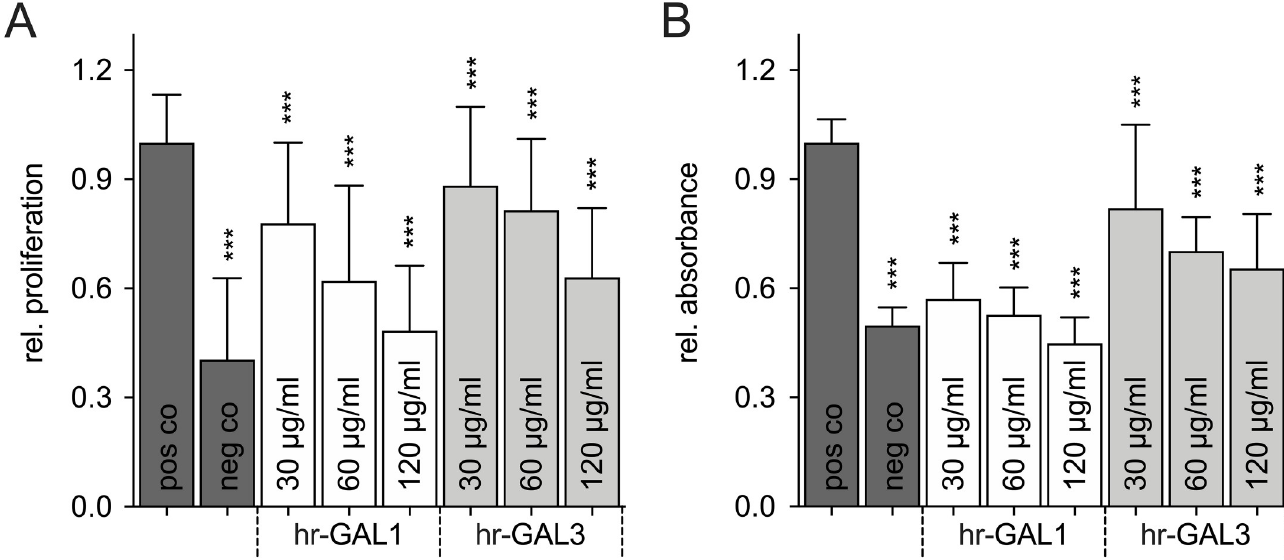
Fig 3. hr-GAL1 and 3 block cell proliferation of HRMEC in vitro . BrdU ELISA (A) and WST-1 (B) assay after treatment of HRMEC with 30, 60, and 120 μ g/ml hr-GAL1 and 3 for 48 h (BrdU) as well as 72 h (WST-1). � co vs all hr-GAL1 and 3 concentrations, ��� p < 0.001; BrdU n = 40 of 5 independent experiments; WST-1, n = 32 of 4 independent